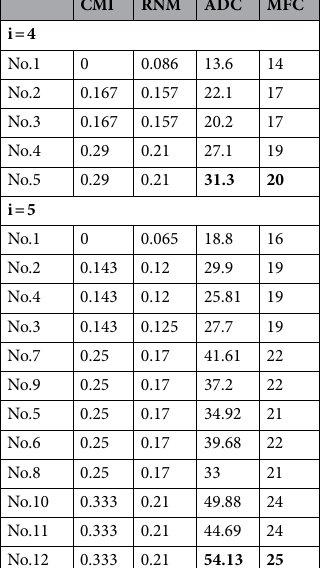
Table 1. Comparison of the relative modularity and overall complexity values. Significant values are in [bold].